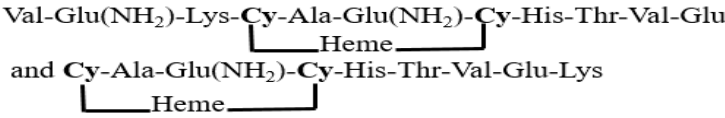
Figure 12. Schematic design of the nanoporous anodic alumina-human serum albumin-thionine (NAA-HSA-TH) for the determination of cathepsin B (Cat B) using interferometric reflectance spectroscopy (IRS).